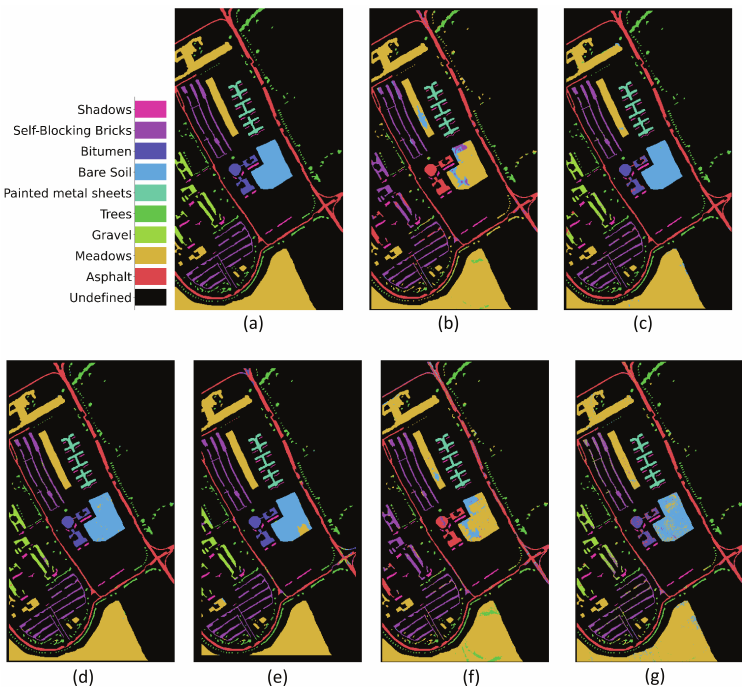
Figure 15. Classification results of Pavia University: ( a ) ground truth, ( b ) Luo model, ( c ) Li model,